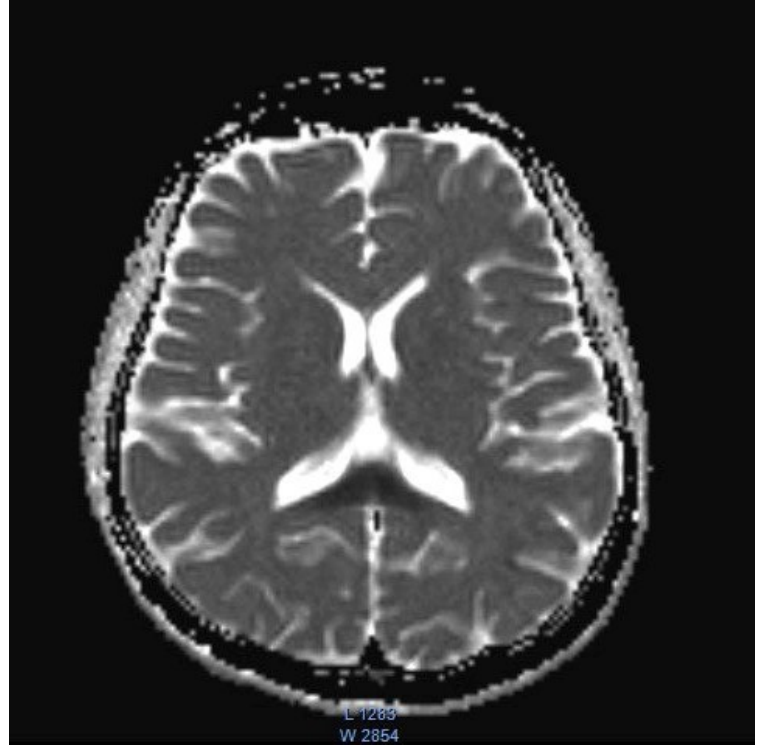
Figure 4. The reduced ADC values within the splenium of the corpus callosum.